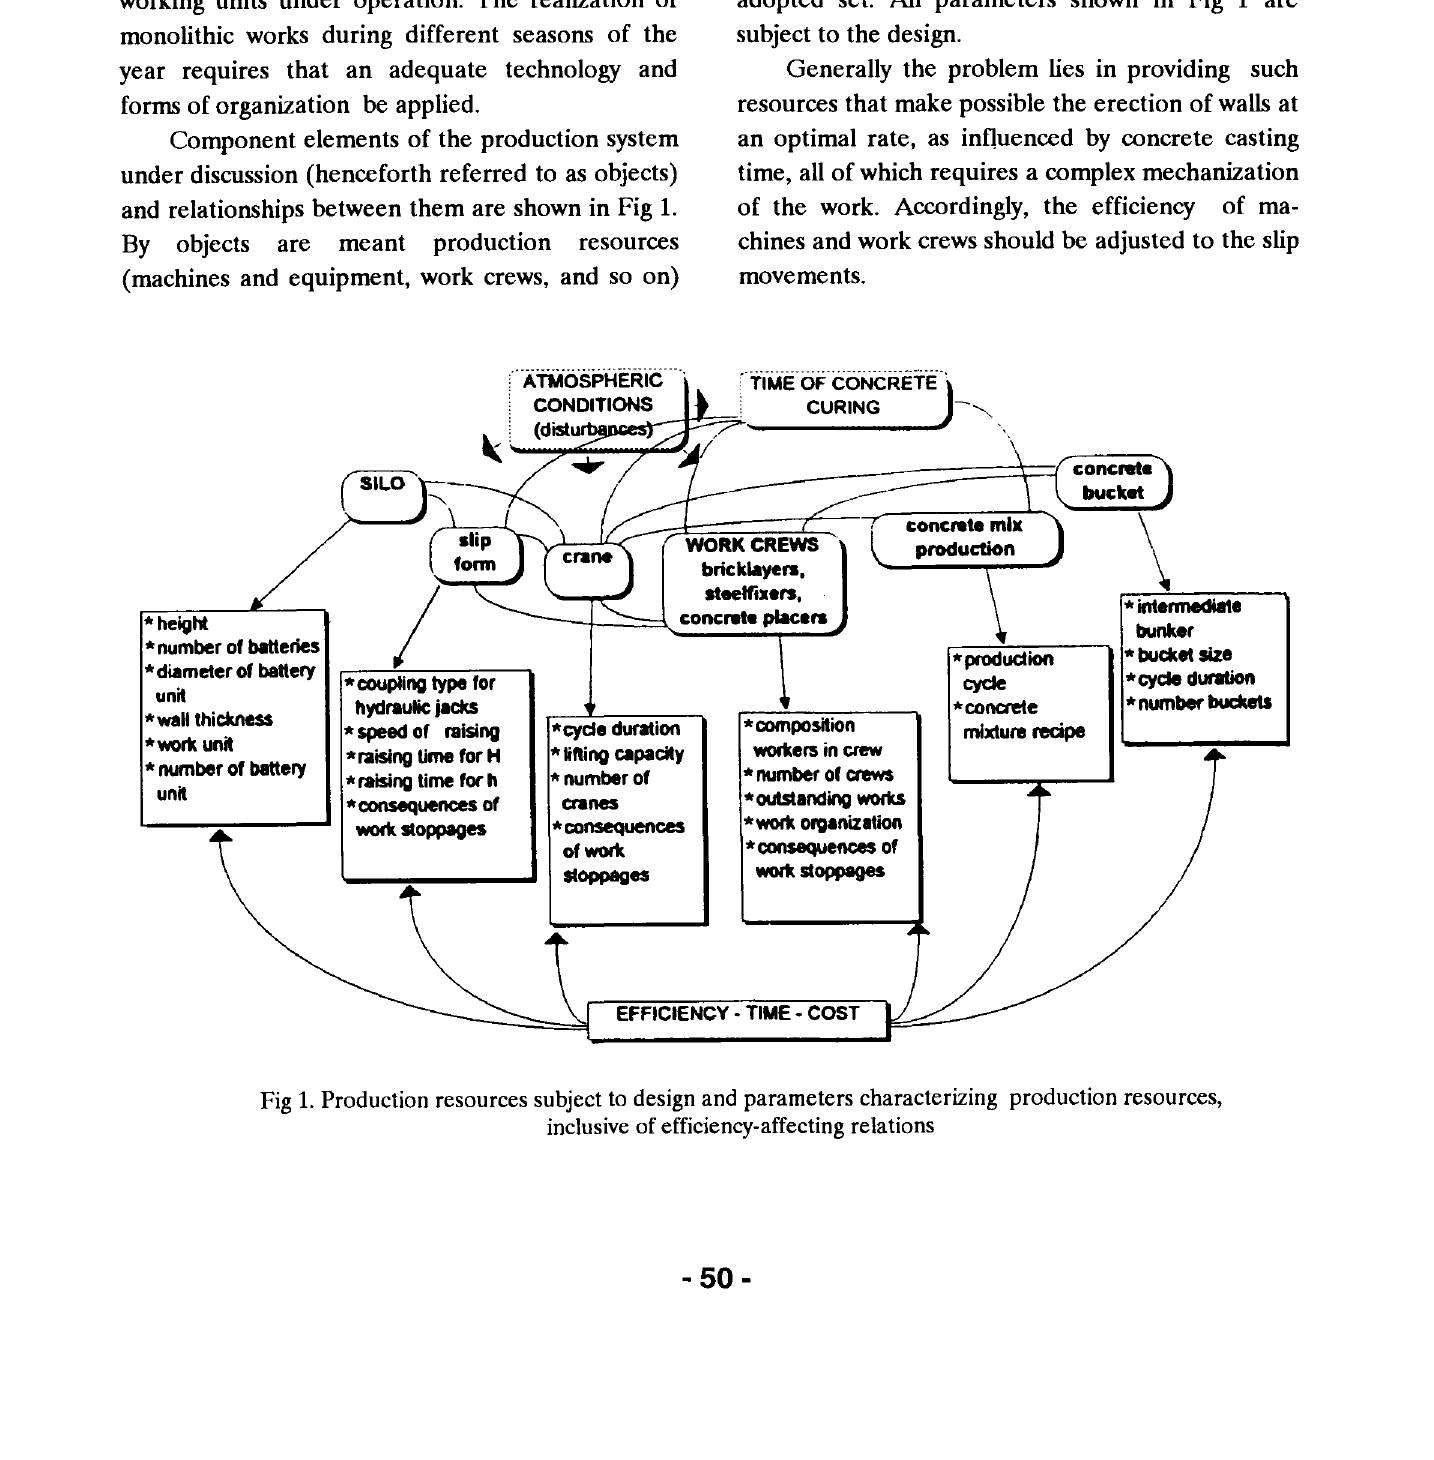
Fig 1. Production resources subject to design and parameters characterizing production